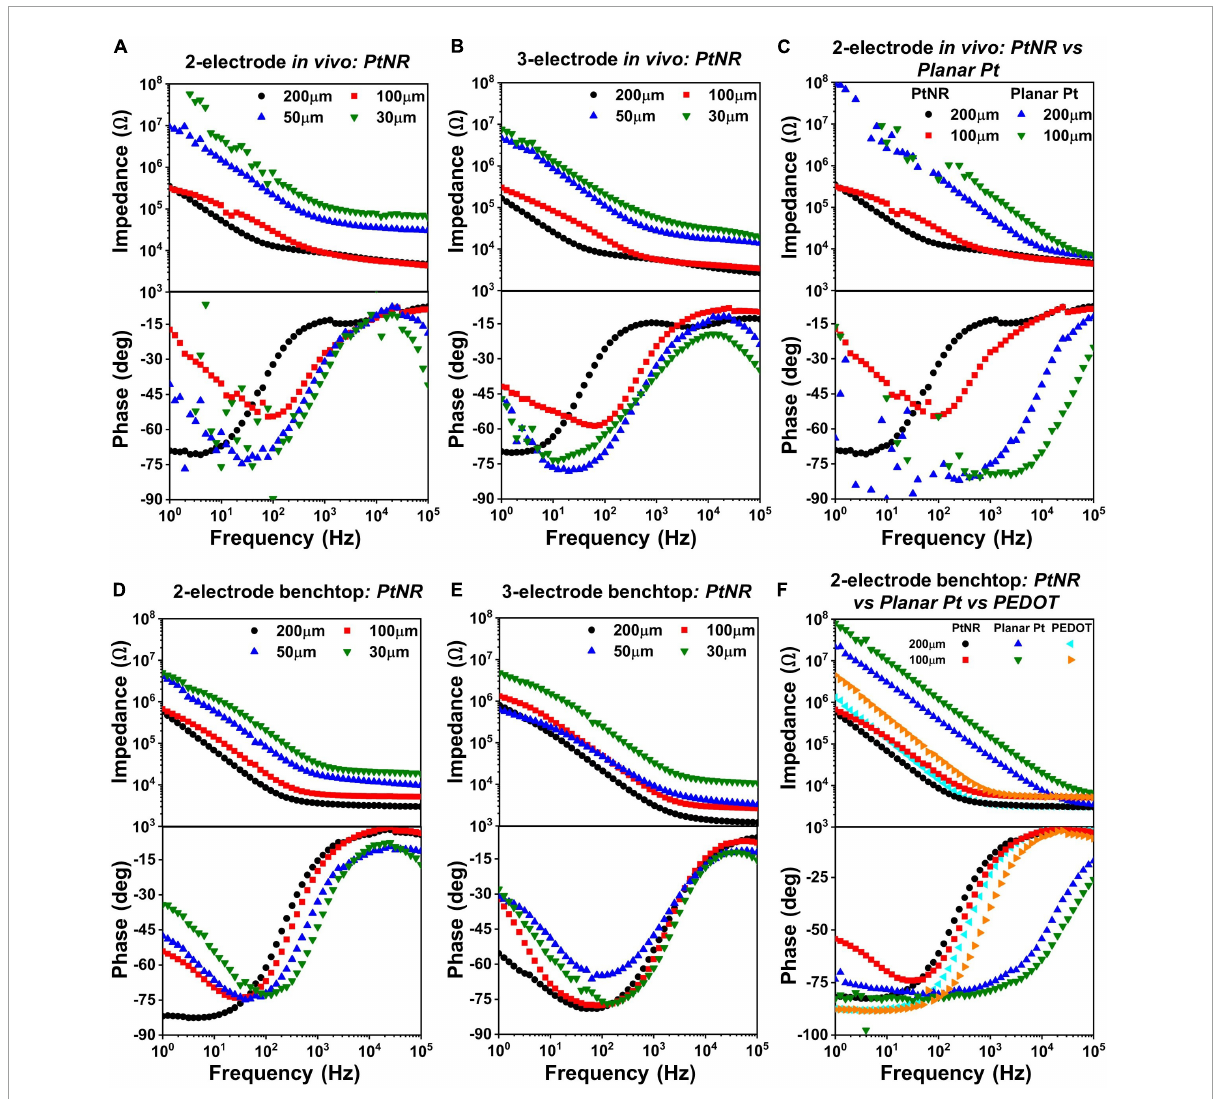
FIGURE4 Diameter-dependent measured EIS spectra in vivo for PtNR contacts in (A) 2-contact configuration and (B) 3-contact configuration, and in benchtop for (D) 2-contact configuration and (E) 3-contact configuration. Side-by-side comparison of 2-contact PtNR and planar Pt contacts (C) in vivo . (F) Side-by-side comparison in benchtop, of PtNR, planar Pt and PEDOT.